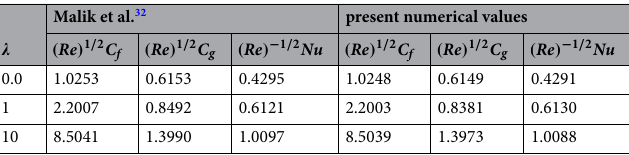
Table 3. Validation of present results for skin friction coefficients and temperature gradient.